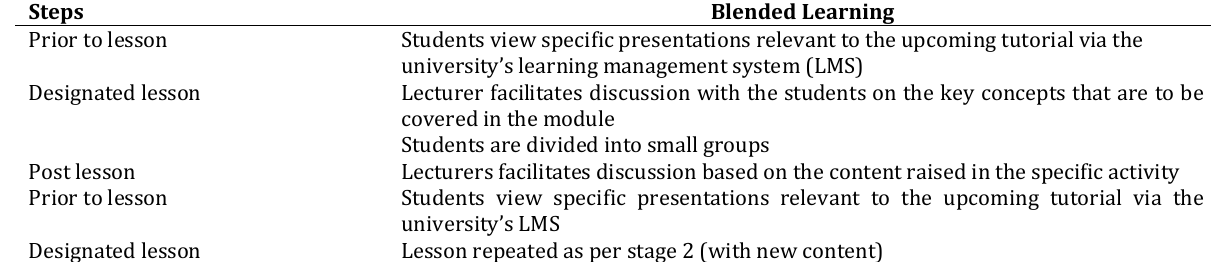
Table 2. Data description of Students Knowledge Score (n=474) Data